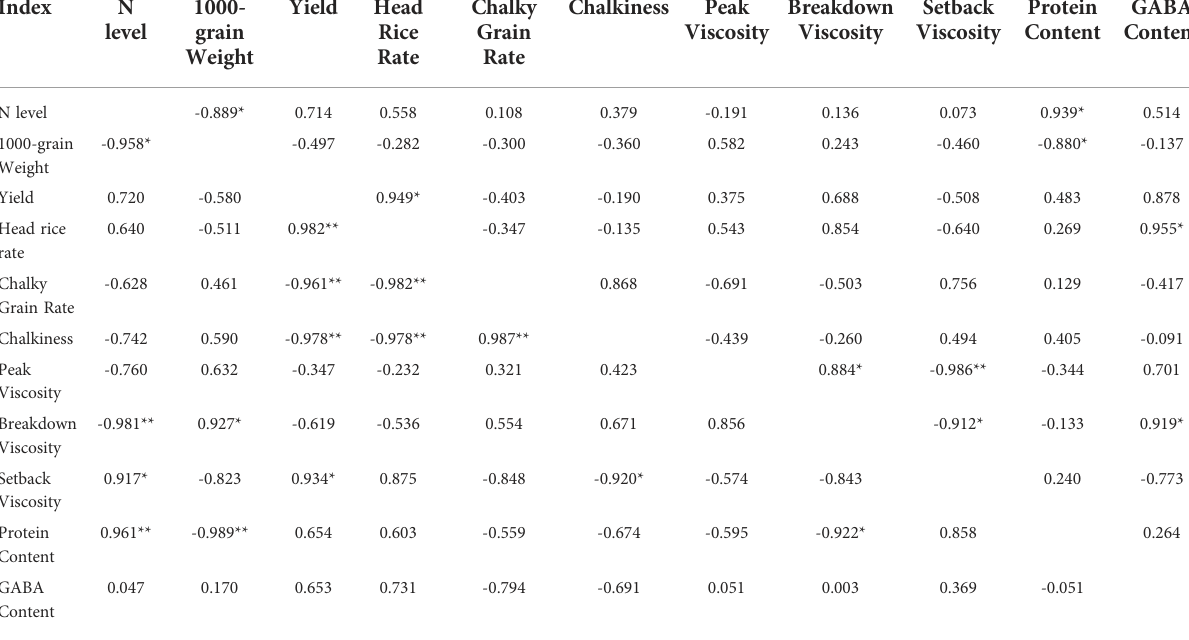
TABLE 7 Correlation analysis between yield and quality of J20 (below the diagonal) and Koshihikari (above the diagonal).